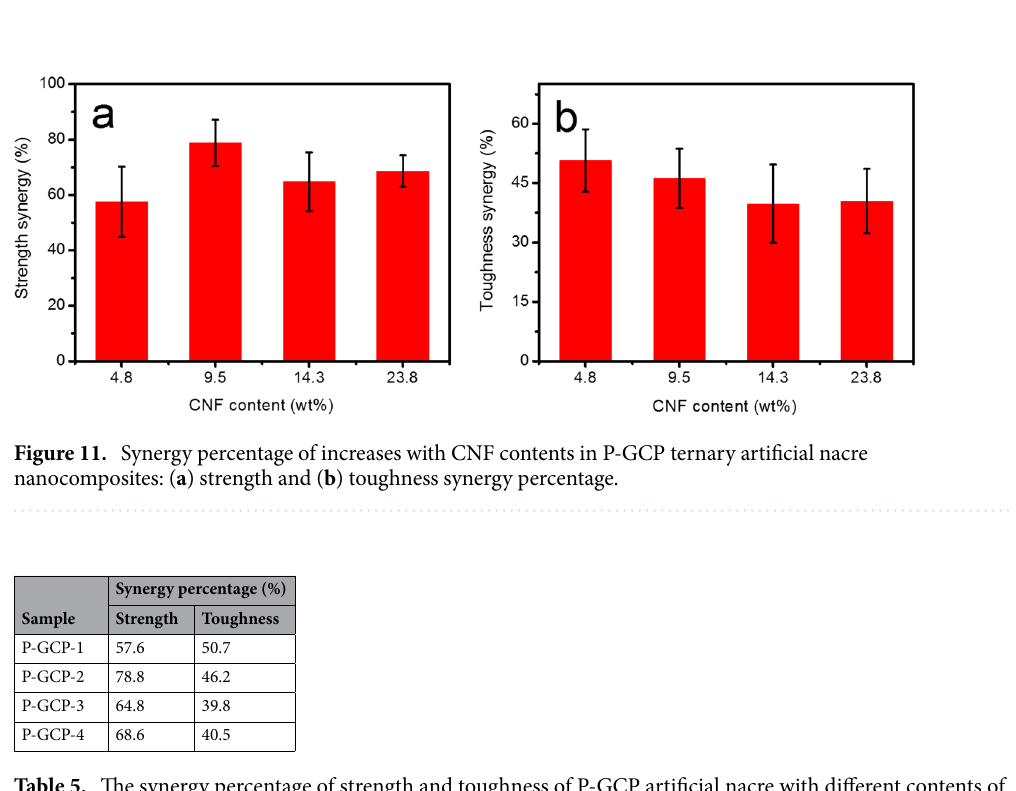
Table 5. The synergy percentage of strength and toughness of P-GCP artificial nacre with different contents of CNF.